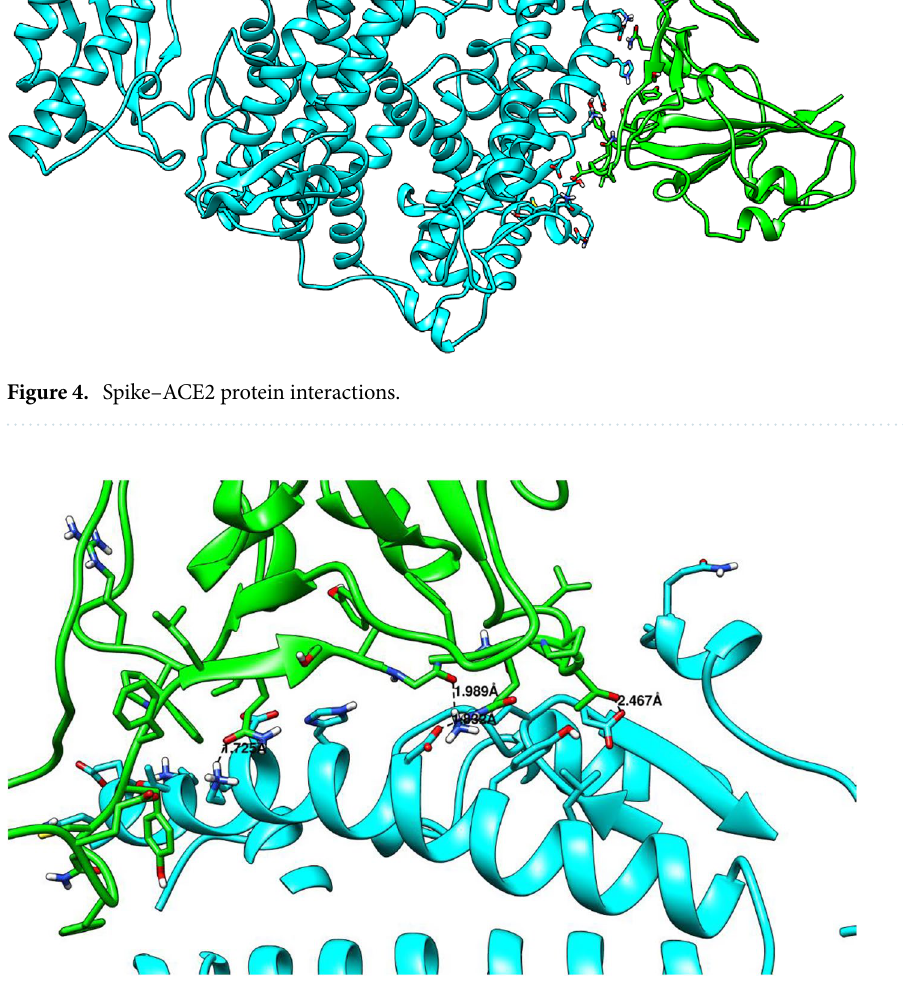
Figure 5. The interactions of Spike–ACE2 with highlighted hydrogen bonds.